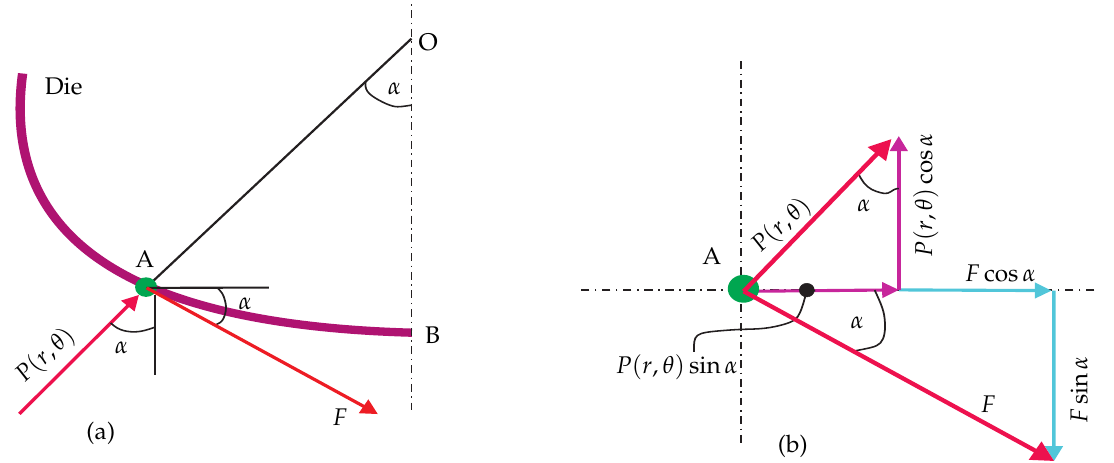
Figure 5. Component force. (a) Direction of the two forces, (b) Resolved force that act on rolling die